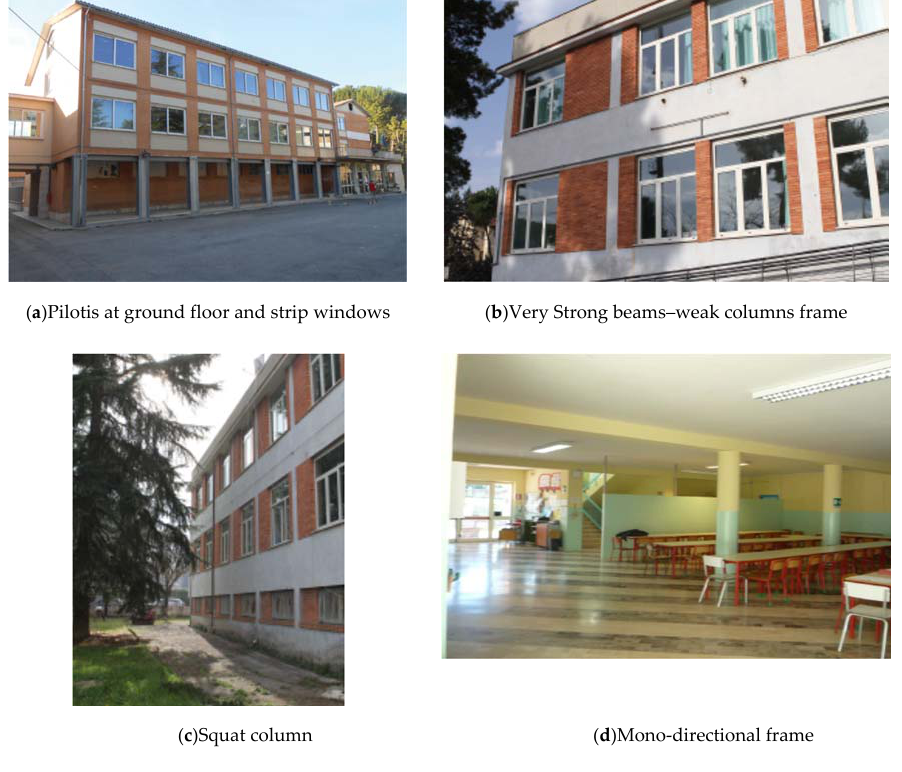
Figure 10. General views of some existing school buildings in the Abruzzo region designed for gravity loads only.